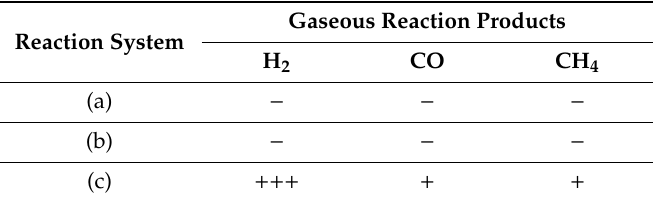
Table 6. Photocatalytic reaction for three di ff erent